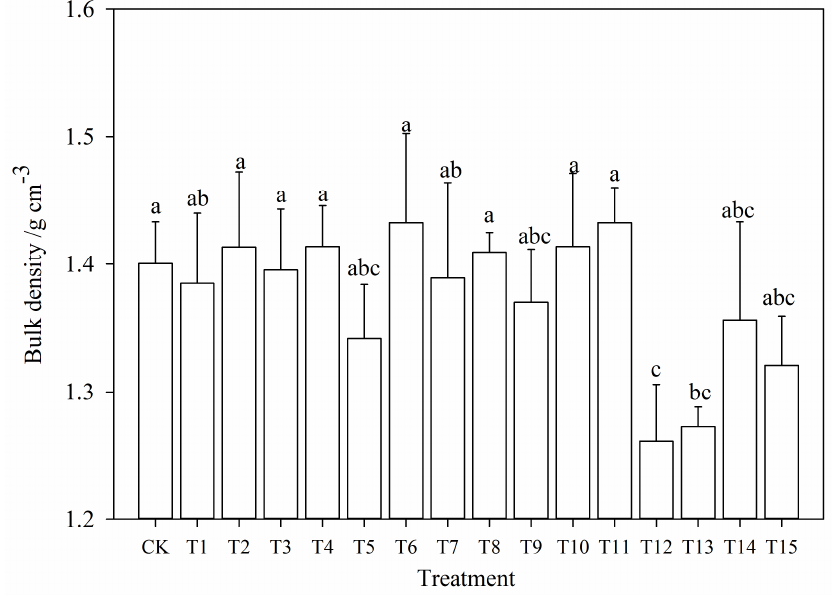
Figure 2. Soil bulk density (BD) of different treatments after maize planting. The error bar is standard deviation, and the different letters indicate significant difference under different treatments during maize ripping at p < 5%.